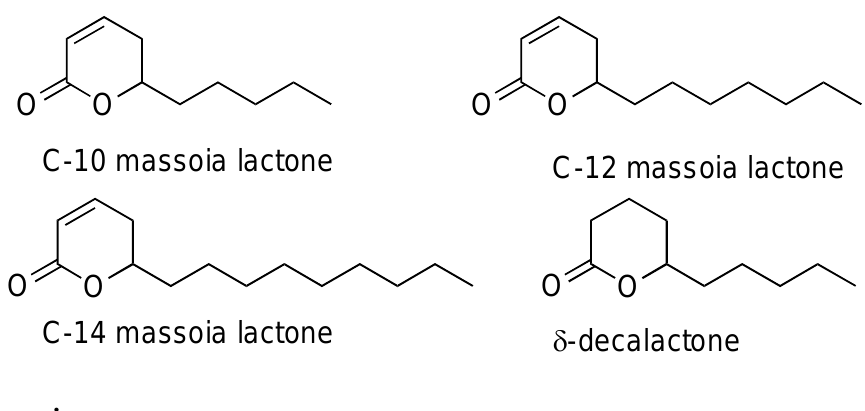
Figure 1 . Structures of the massoia lactones from C. massoia oil.